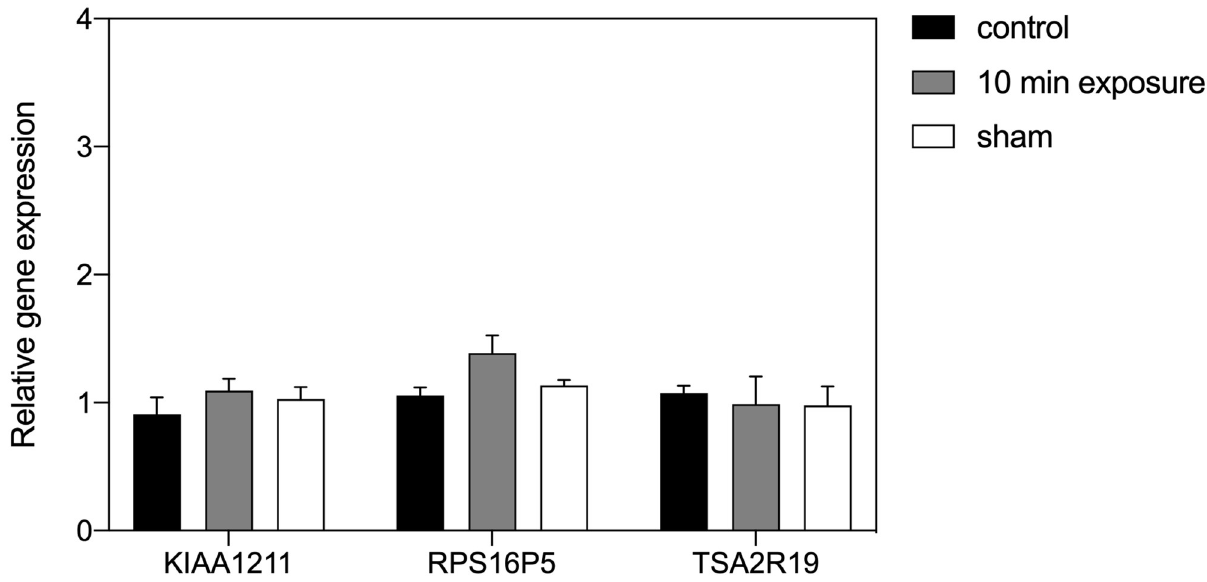
Fig 3. Effect of a 2 mT static magnetic field on HEK293 gene expression. The results are presented as the Relative expression of the ROS-related genes KIAA1211, RPS16P5 and TAS2R19 after 2 mT (grey bar), Control (black bar) or Sham (white bar) exposure conditions. Control cell cultures were exposed to the local magnetic field. The Sham condition was provided by the Helmholtz coil that generated the 2mT magnetic field but with antiparallel currents. Data are shown as mean ± SE of three independent experiments (N = 3).